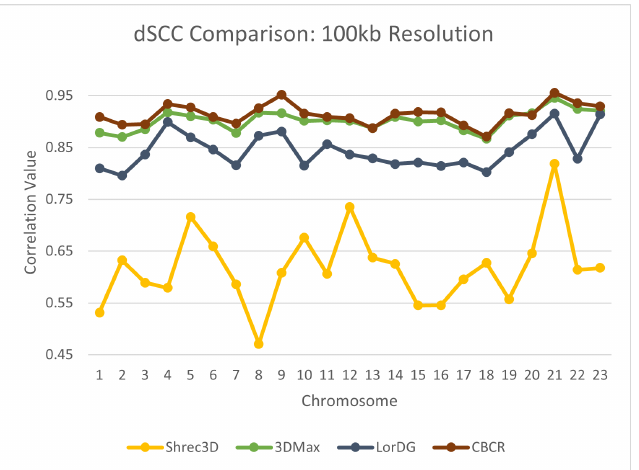
Figure 12. Comparison of dSCC between CBCR and other methods on chromosomes 1–23 at 100 kb